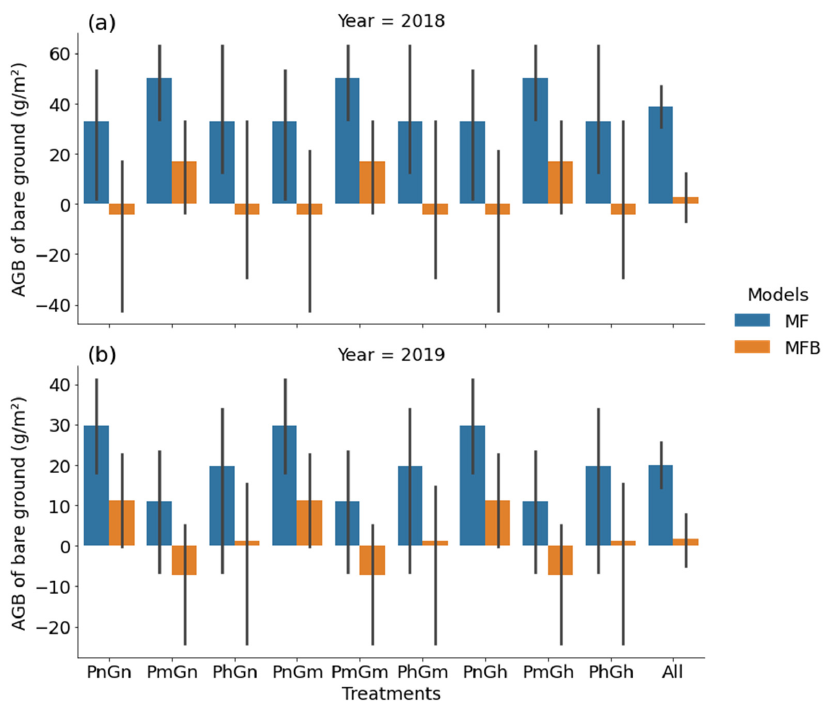
Figure 10. The over- or under-estimation of AGB caused by bare ground (MF is the mowing ratio modified model, MFB is the model modified by both mowing ratio and bare ground metrics): ( a ) estimation errors of bare ground in 2018; ( b ) estimation errors of bare ground in